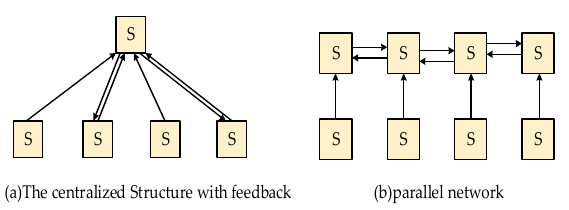
Figure 4. Multi-connected fusion structures.